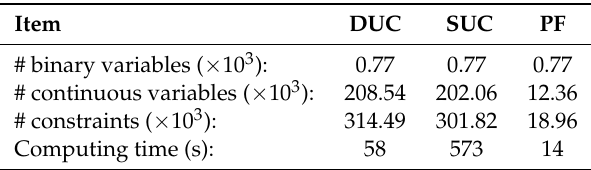
Table 2. Computational size and computing